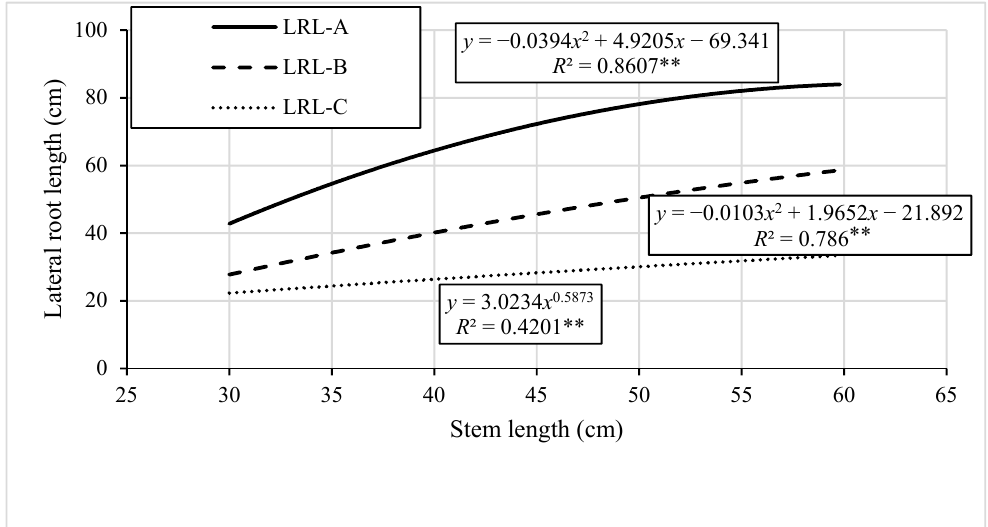
Figure 5. Relationship between stem length and lateral root length of maple seedlings in three areas